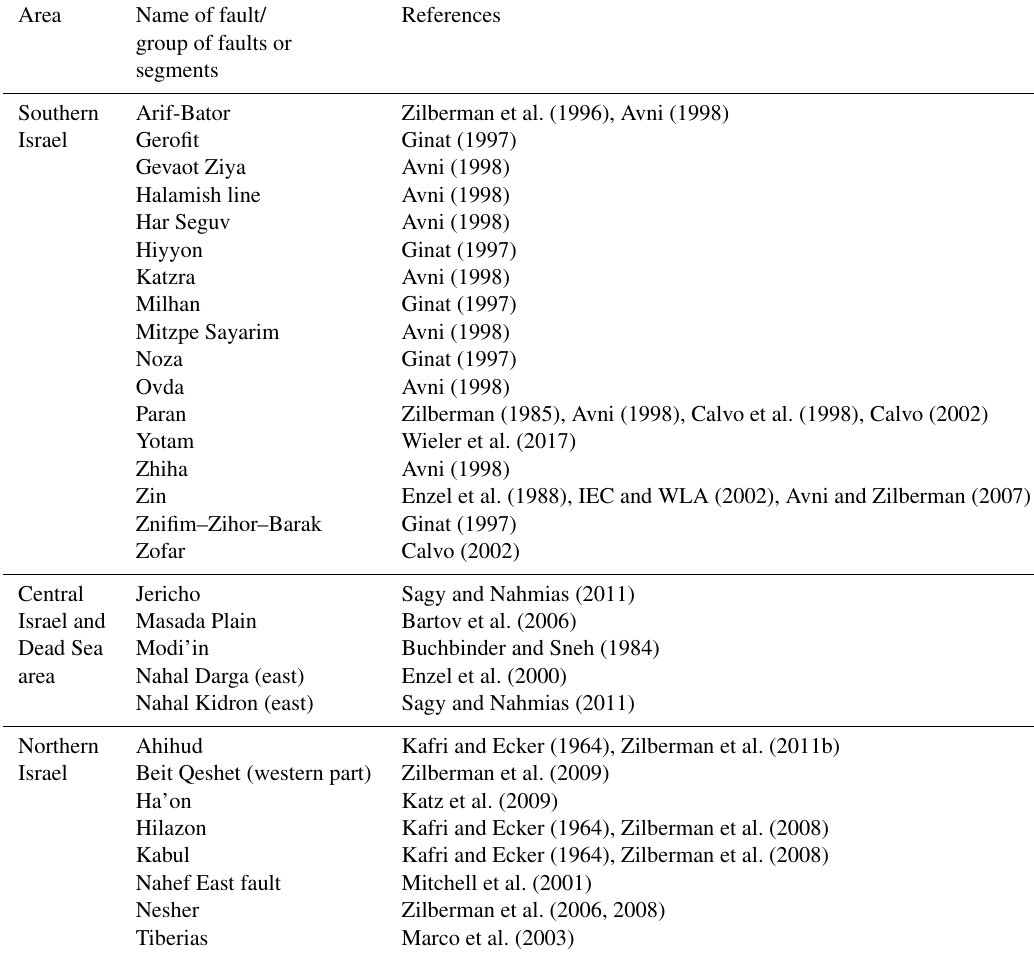
Table A1. References for faults and fault segments that have been marked based on papers, reports and theses. Faults are listed in Table 3 if their latest mapping is not updated yet in the 1 : 50000 sheets (as of 2018) or if their definition as Quaternary faults cannot be directly deduced from the geological maps. Fault names are mainly according to the